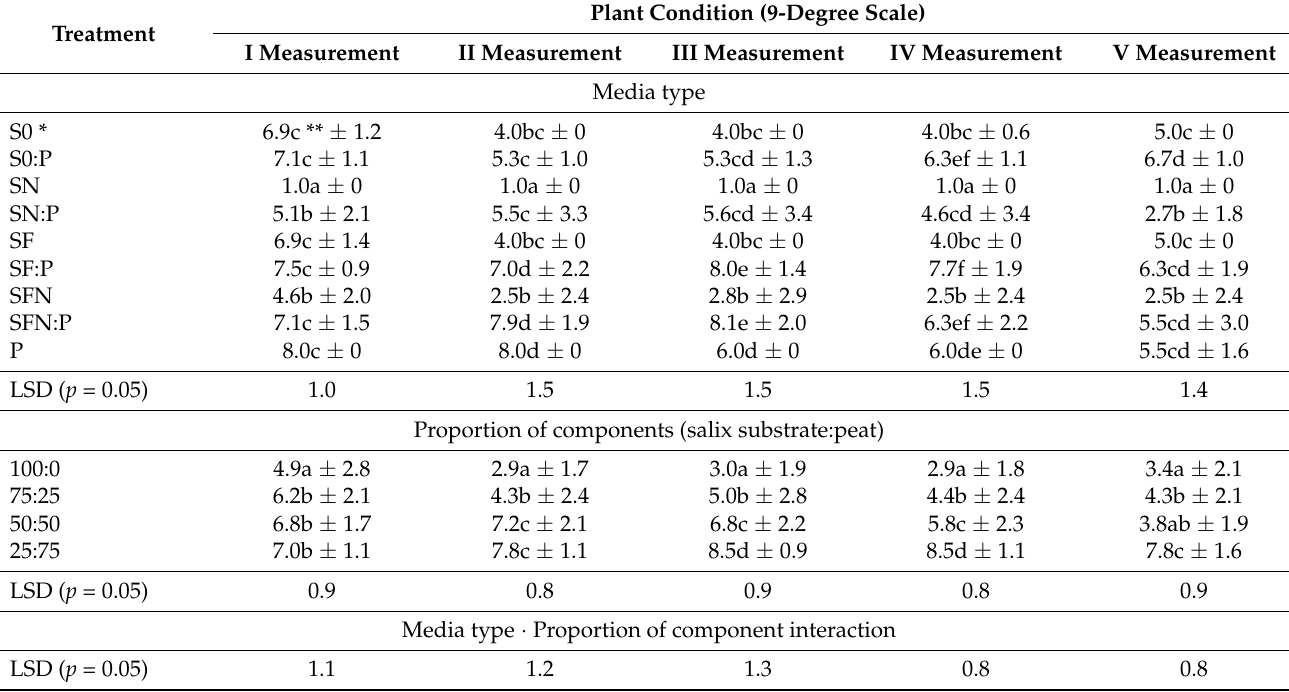
Table 2. The effect of media on the relative condition of the plants (average ± standard